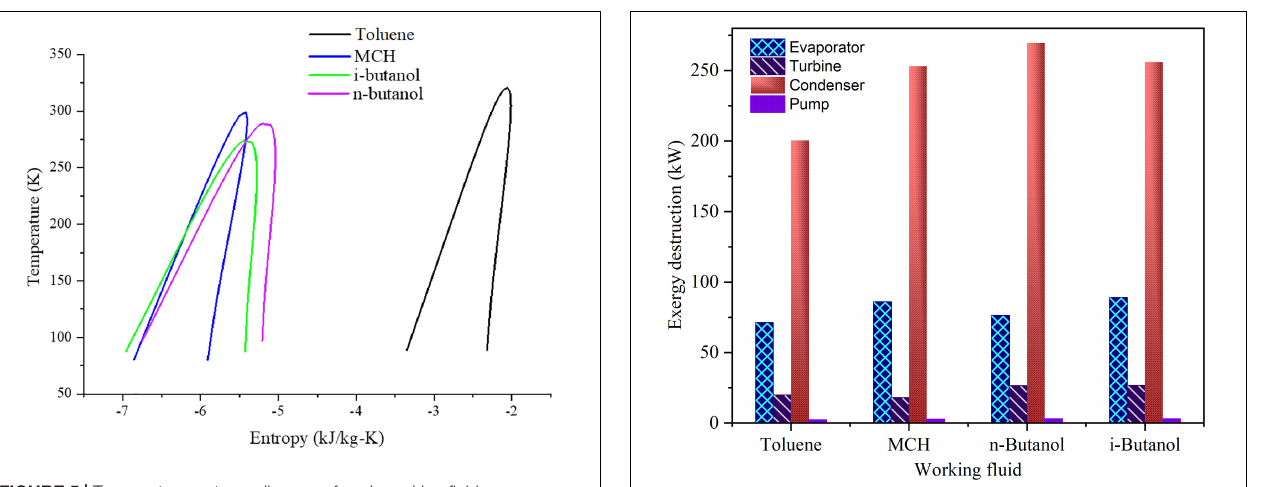
FIGURE 5 | Temperature–entropy diagram of each working fluid.